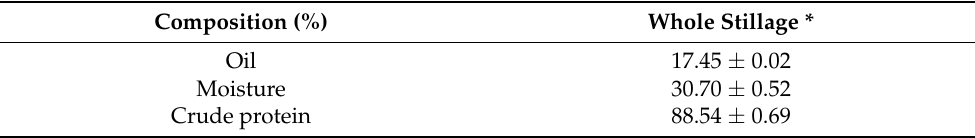
Table 2. Composition of whole stillage used in the experiment. Composition (%) Whole Stillage * Oil